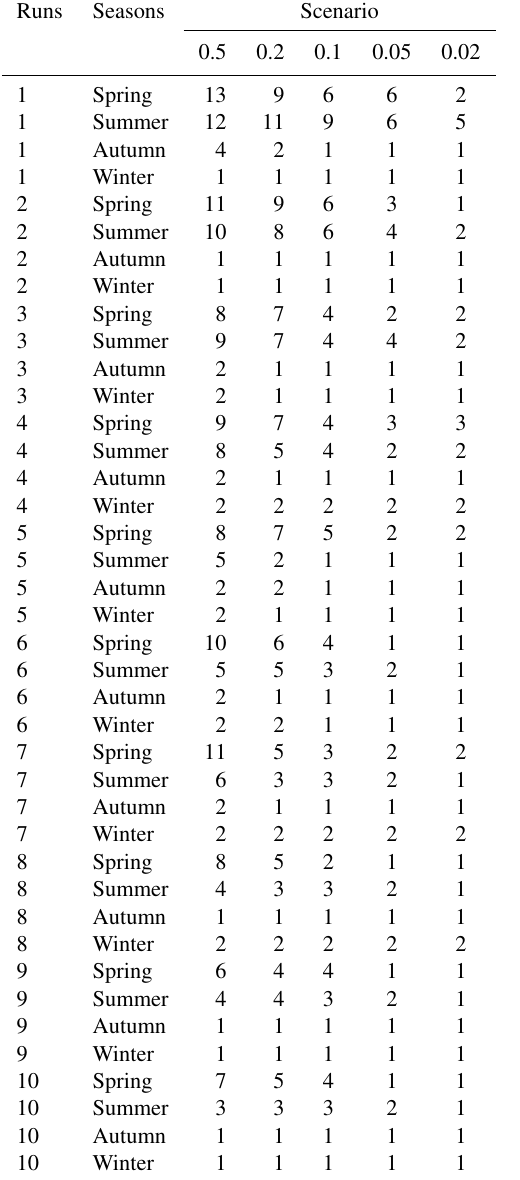
Table 6. Statistics of extreme precipitation events from 1–10 runs at Ganxian station from 2009 to 2014.